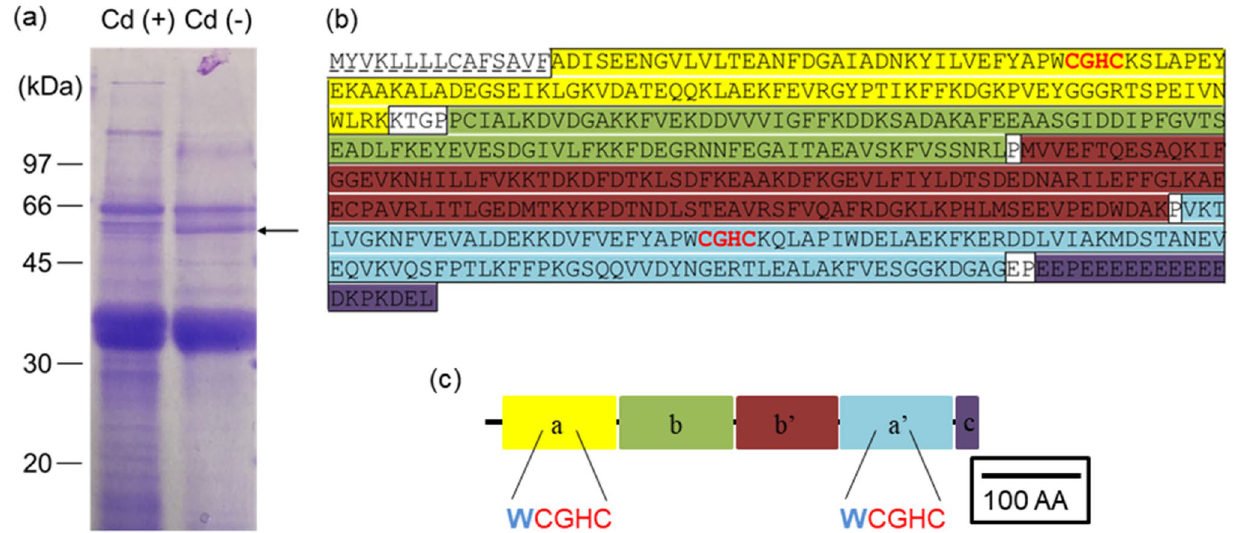
Figure 3. Identification of Cd-binding proteins by Cd binding competition experiment. ( a ) Cd binding competition experiment was conducted on the supernatant of the extracted visceral of oyster with and without addition of Cd. Cd (+): added with Cd. Cd (−): without Cd. Arrow: target band with high reproducibility. ( b ) The amino acid sequence of PDI. The underlines showed the signal peptide. The bold characters showed two